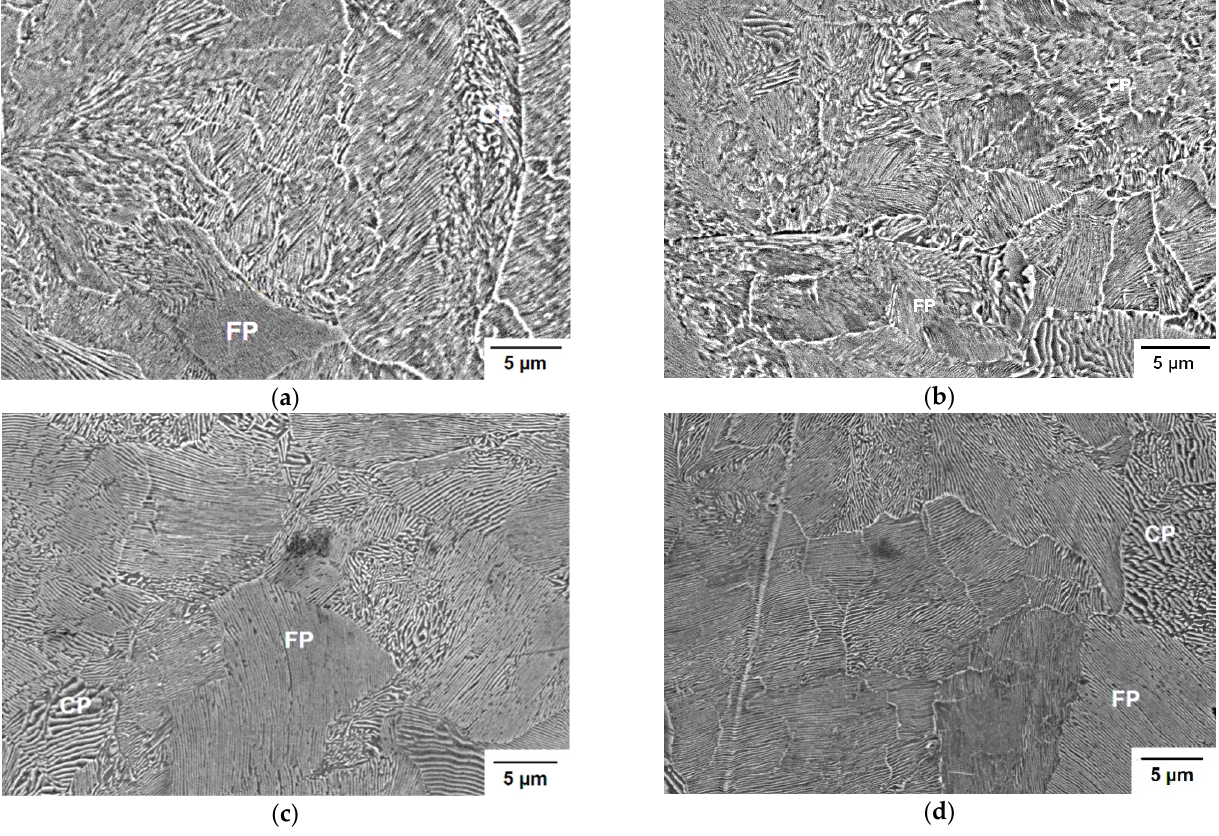
Figure 7. SEM micrographs showing the different pearlite colony sizes with coarse pearlite (CP) and fine pearlite (FP), for ( a ) specimen 1, ( b ) specimen 2, ( c ) specimen 3, and ( d ) specimen 4.